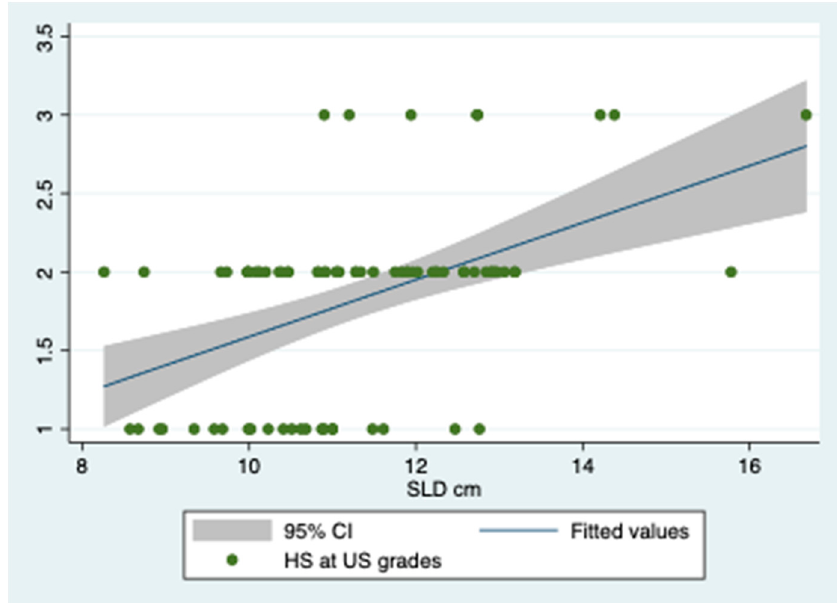
Figure 2. Association between spleen length and severity of hepatic steatosis. Legend to Figure 2: SLD, spleen longitudinal diameter; HS at US, hepatic steatosis at ultrasonography. Table 9. Evaluation of the influence of BMR in predicting HS by SLD. Extended Linear Regression